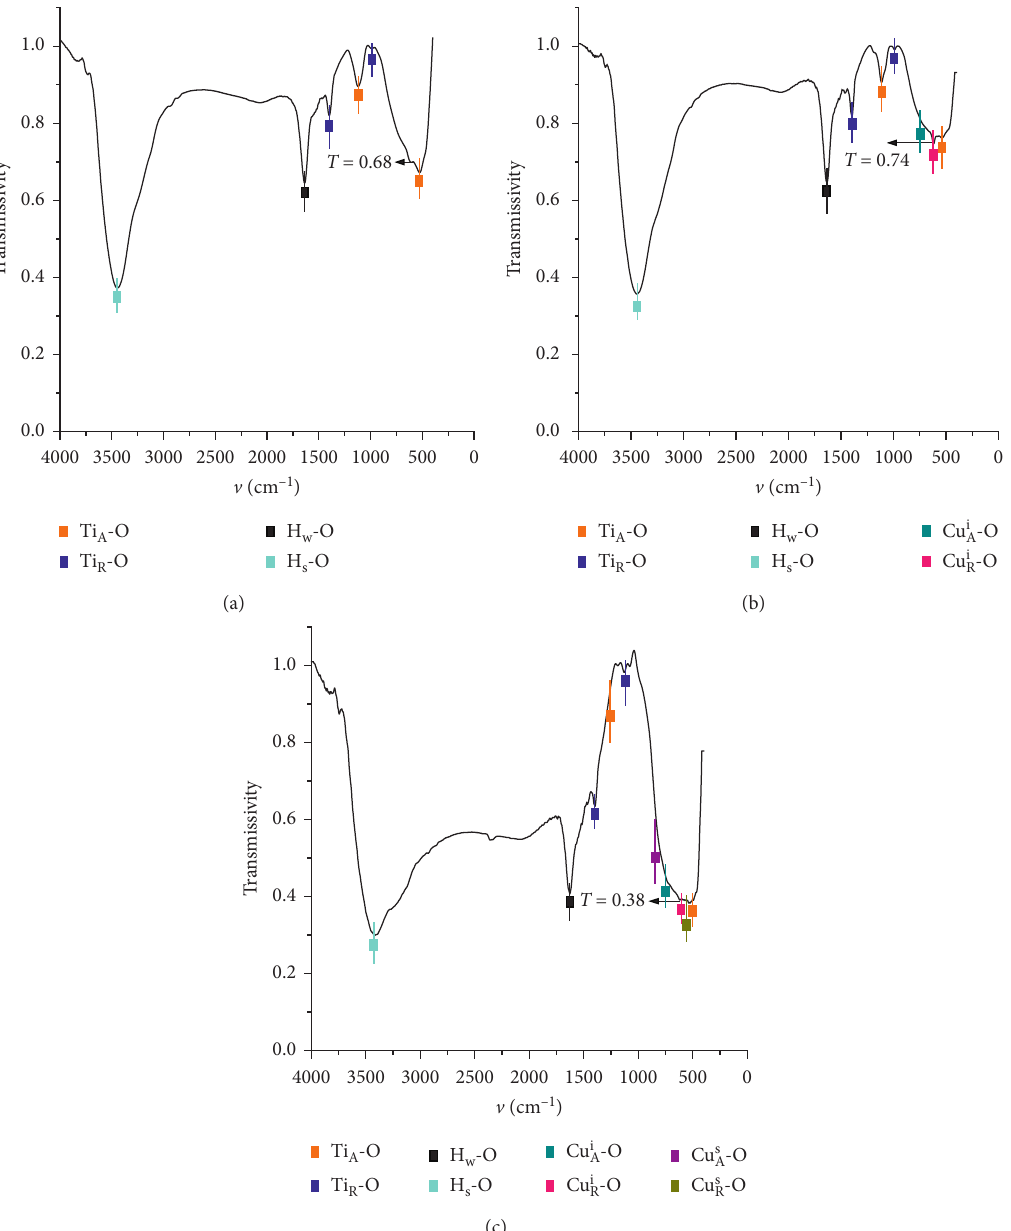
Figure 4: Full wave number section of the Infrared Spectra of the Cu-doped TiO calcination temperature (550 ° C).(a) Undoped. (b) 2.5mol%Cu. (c)